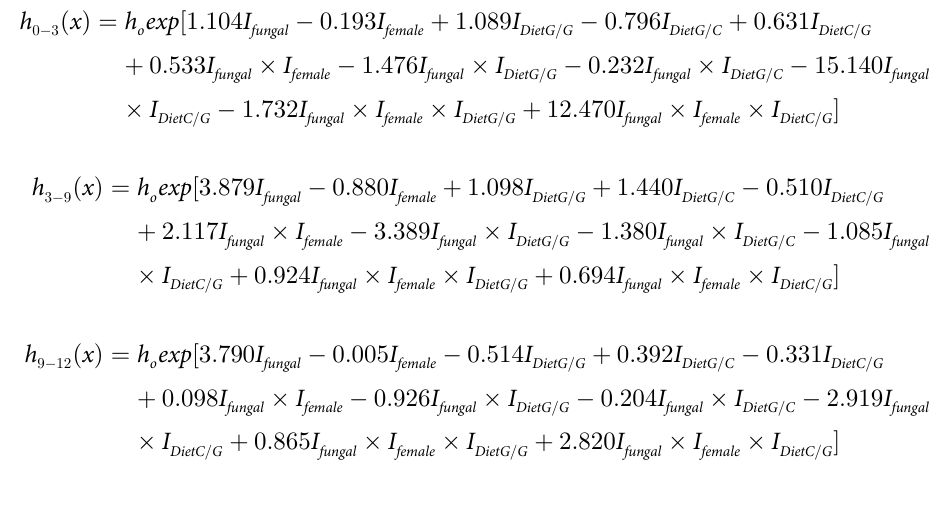
On Day 12 from the egg, flies were transferred, in groups of 15 males and 15 females, to fresh vials containing an assigned diet: cornmeal (C) or glucose (G) (ingredients provided above). To separate and count the flies by sex, we anesthetized them using a CO gun for 10 2 seconds and put them on a CO pad for 3 minutes. On day 15 from egg, the flies were sprayed 2 with either GHA and control suspensions. Sprayed flies were moved to cages and fed with either the C or G diets. The before and after spray diet combinations are summarized in S1 Table. Approximately 150 flies were sprayed per condition and kept in plexiglass cages (vol- ume = 450 cm 3 ). Dead flies were removed and sexed daily for 12 days (until age 27 days from egg). The experiment was replicated three times. Statistical analysis of Experiment 3 . Sexual dimorphism in survival after GHA inoculation and different diet conditions was analyzed similarly as in Experiment 1. A piecewise PH model was proposed (see Model 3). coxph ð time ; event Þ